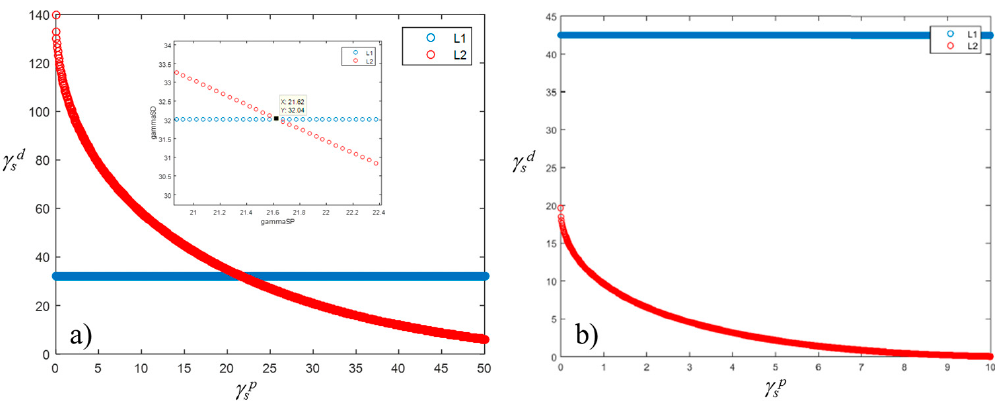
Figure 11. Graphical solution of the SFE equations’ system with ( a ) and without ( b ) solution.